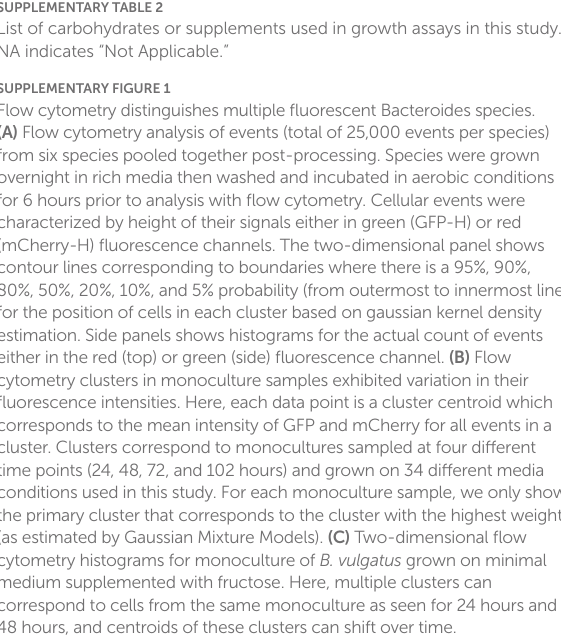
SUPPLEMENTARY FIGURE 1 Flow cytometry distinguishes multiple fluorescent Bacteroides species. (A) Flow cytometry analysis of events (total of 25,000 events per species) from six species pooled together post-processing. Species were grown